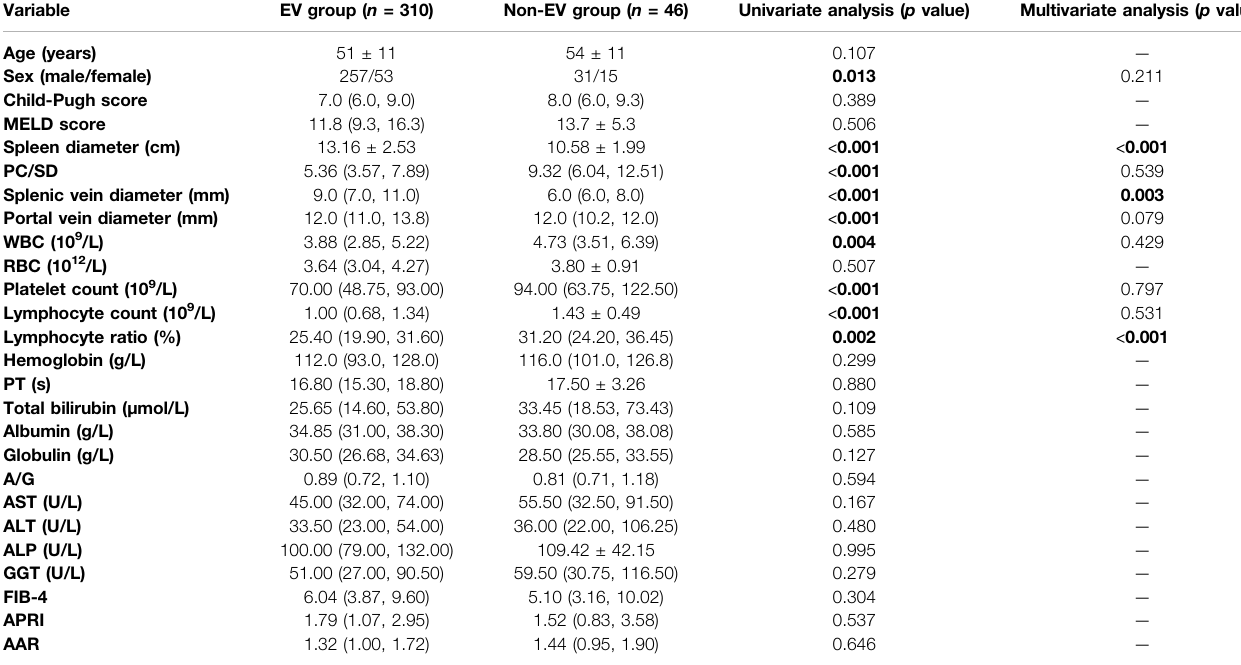
Normallydistributedcontinuousvariablesareshownasmean±standarddeviation.Skeweddistributedcontinuousvariablesareshownasmedian(lowerandupperquartiles).Categorical variable, sex, is shown as absolute numbers. Bold indicates p value < 0.05. AAR, aspartate aminotransferase to alanine aminotransferase ratio; A/G, albumin to globulin ratio; ALP, alkaline phosphatase; ALT, alanine aminotransferase; APRI, aspartate aminotransferasetoplateletratioindex;AST,aspartateaminotransferase;EV,esophagealvarices;FIB-4,Fibrosis-4score;GGT,gamma-glutamyltranspeptidase;PC/SD,plateletcount to spleen diameter ratio; PT, prothrombin time; RBC, red blood cell count; WBC, white blood cell count.